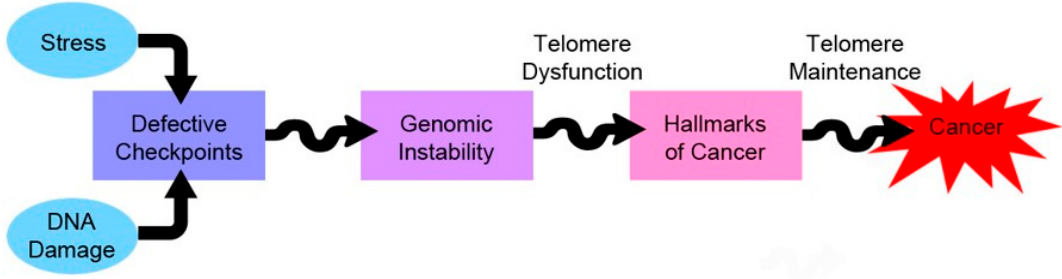
Figure 3. Telomeres and cancer—a love/hate relationship. Telomere dysfunction precipitates the acquisition of other hallmarks of cancer by increasing the rate of chromosomal instability. However, it also poses a threat of induction of cell death during mitosis, due to massive genomic instability— named mitotic